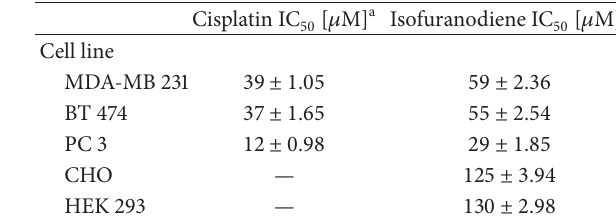
Table 1: Antiproliferative activity of isofuranodiene and cisplatin after 72